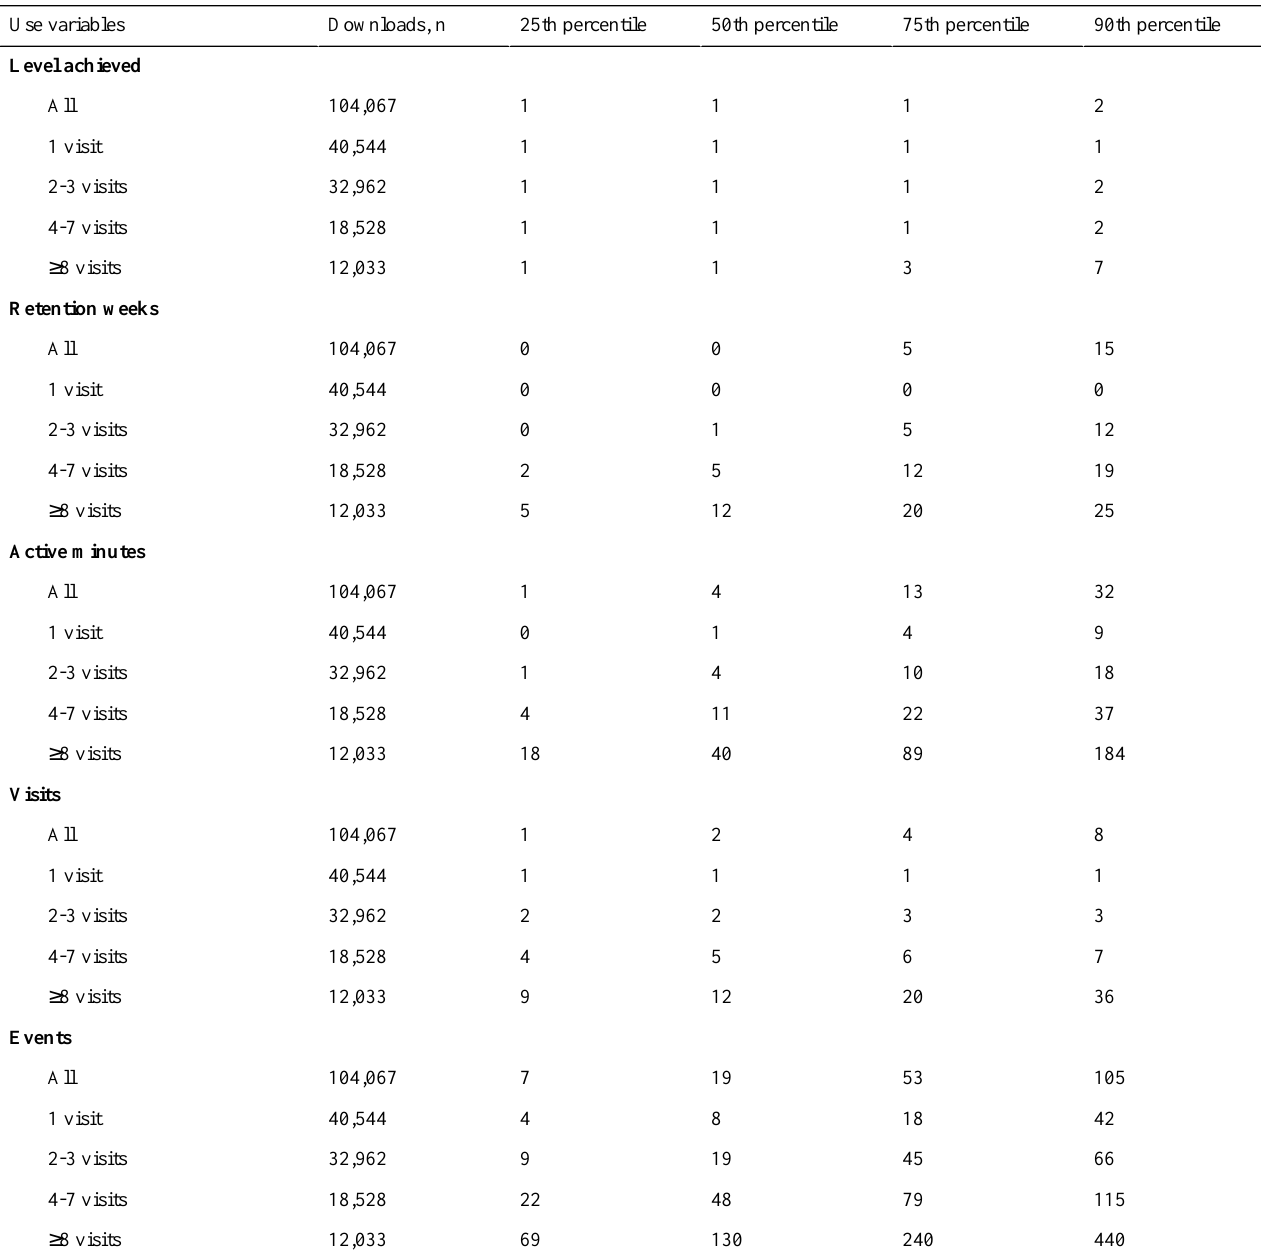
Table 2. Distribution of use variables by user